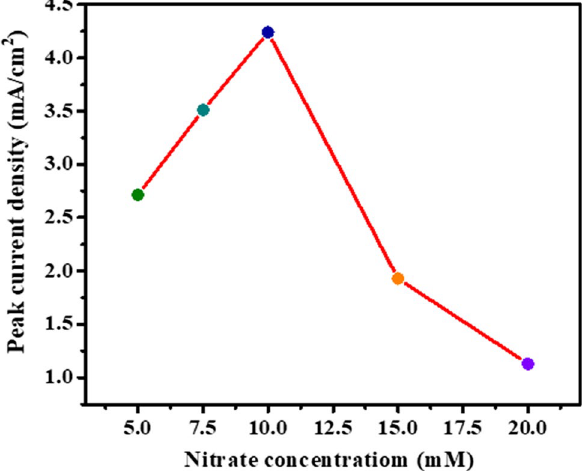
Fig. 10 Calibration curve for peak current versus nitrate concentra- tion (scan rate = 100 mV s −1